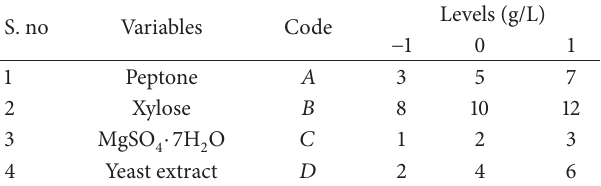
Table 3: Box-Behnken design in coded levels with xylitol yield as response.